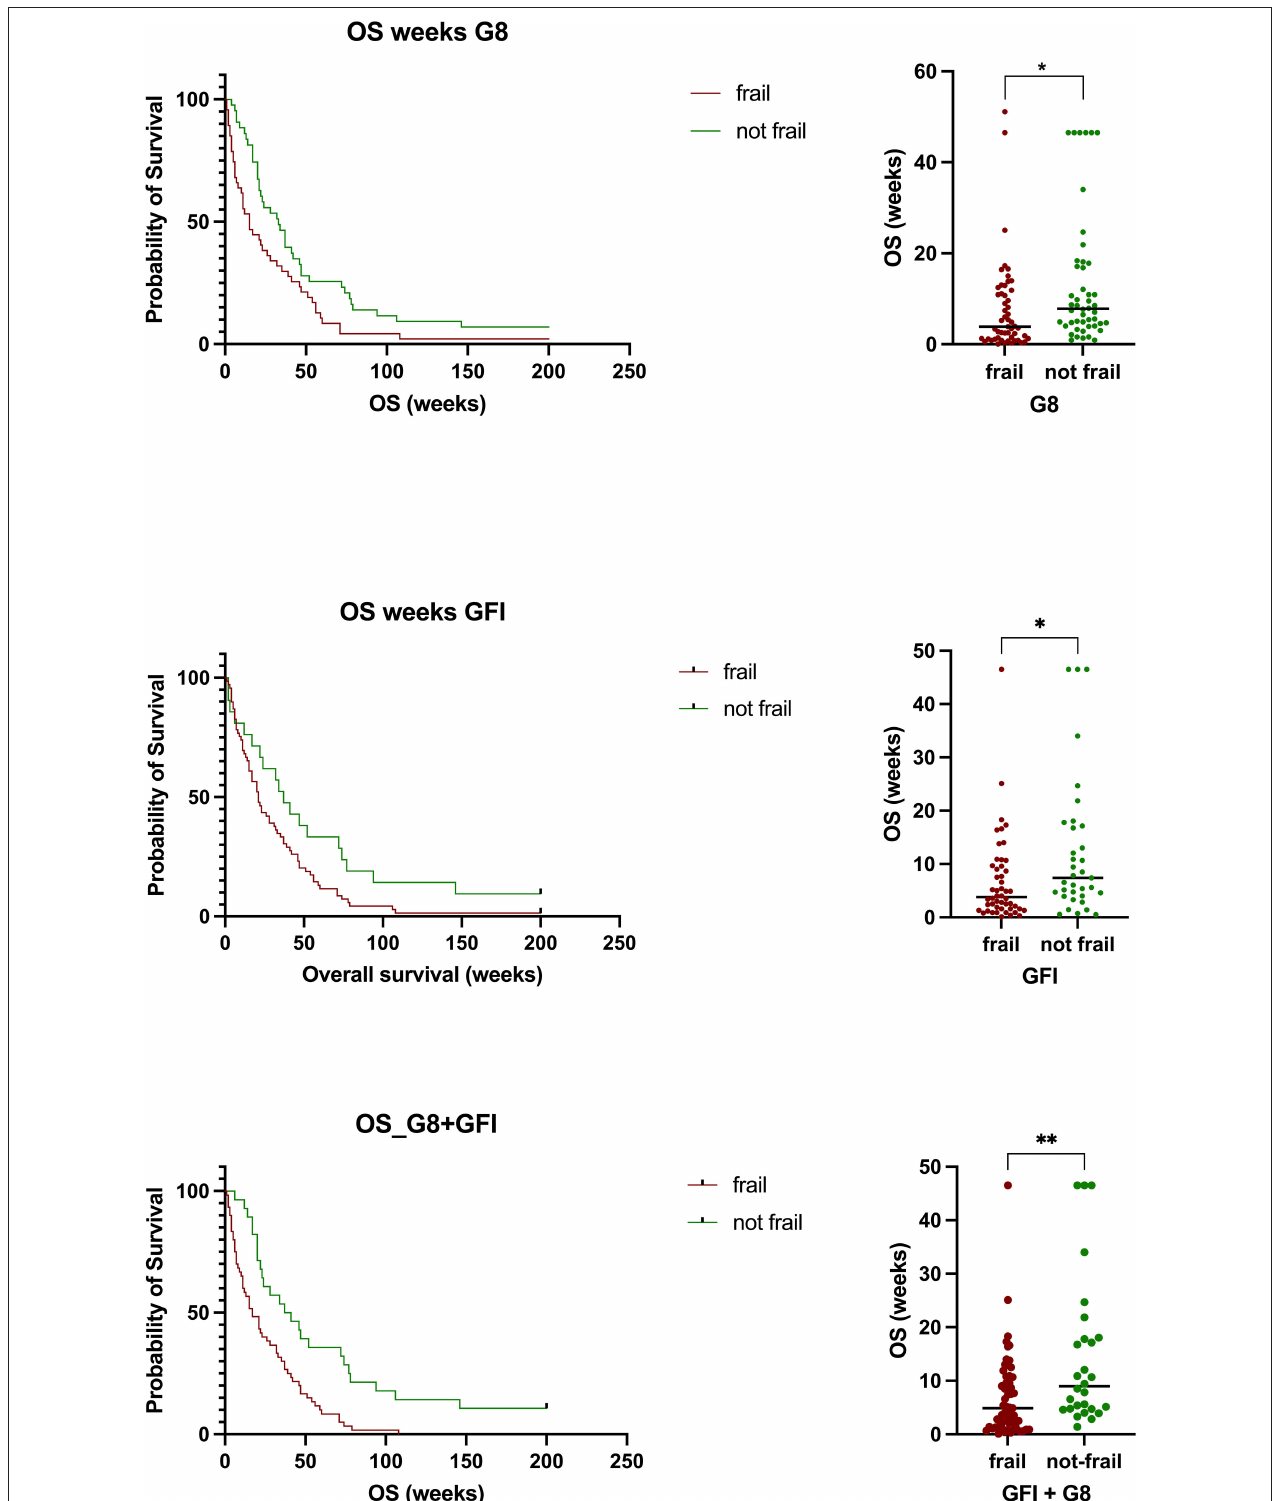
FIGURE 2 | Patients defined as frail by either scale or a combination of both had a statistically significant shorter overall survival compared to those defined as not frail (G8, p = 0.0216; GFI, p = 0.0167) or a combination of both (G8 + GFI, p = 0.0025).